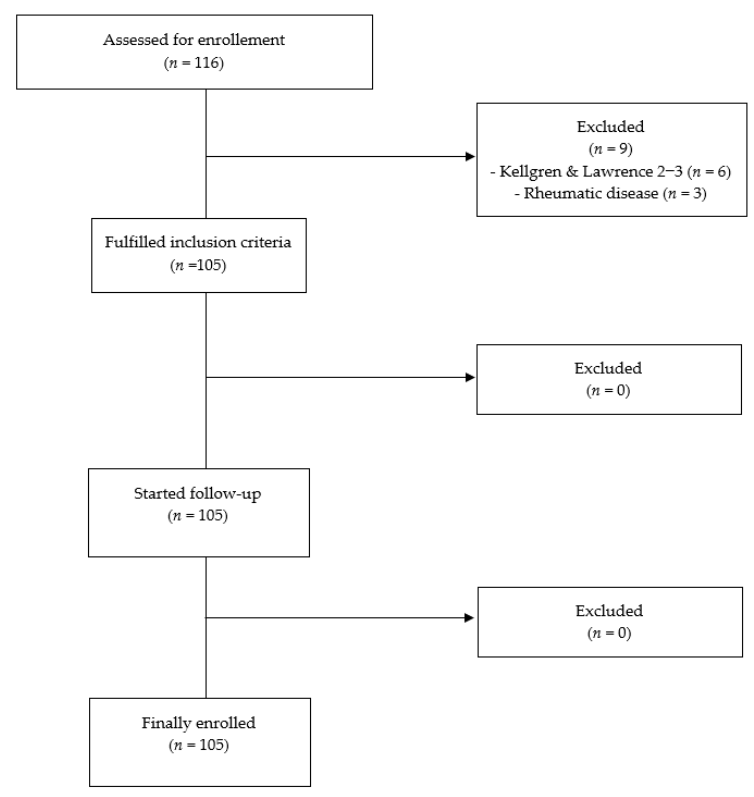
Figure 1. Study flow chart.